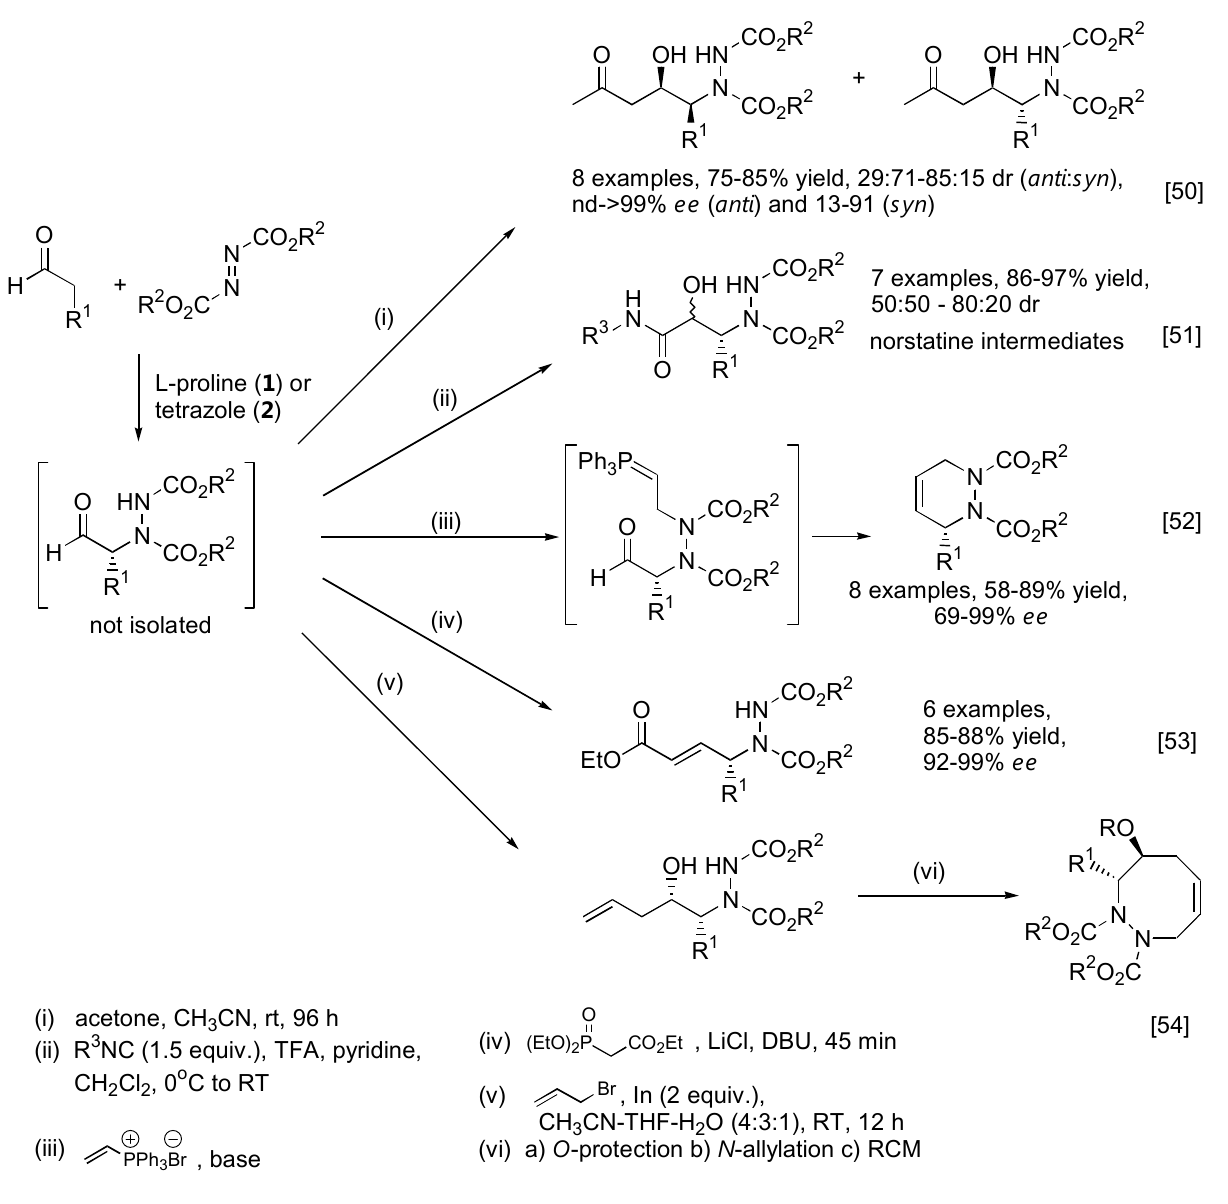
Figure 12. Transformation of  -hydrazinoaldehydes to more complex products or intermediates.